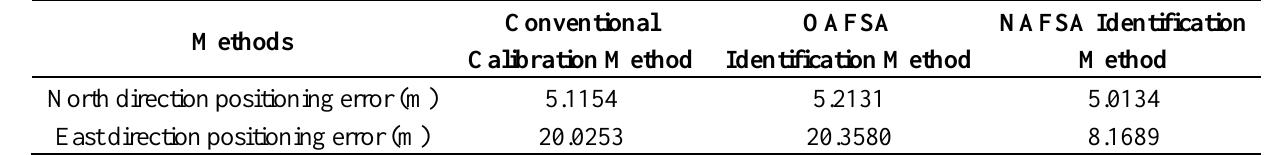
Table 6. Dynamic positioning errors of three different